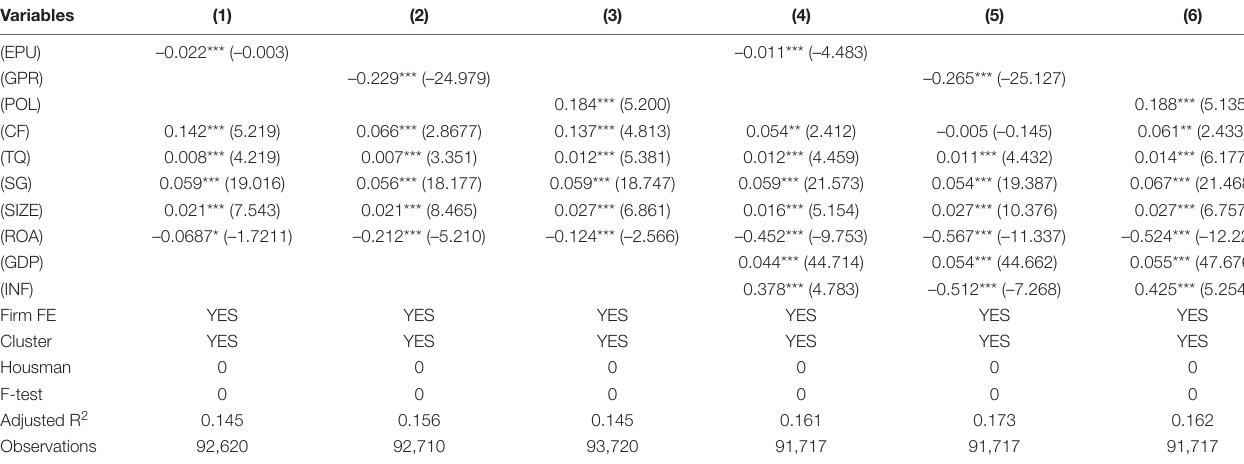
TABLE 3 | Actual financing results.